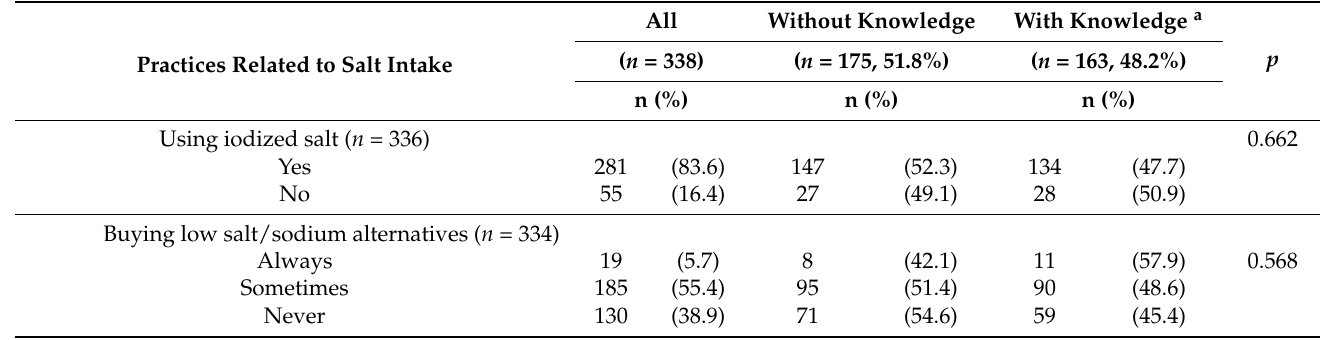
Table 2. Participants’ practices related to salt intake ( n =